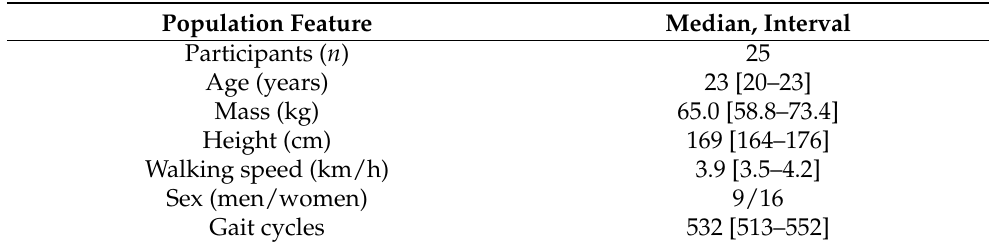
Table 1. Features of the population. Results are written under the form median [Q1–Q3], with Q1 and Q 3 being the first and third quartiles,